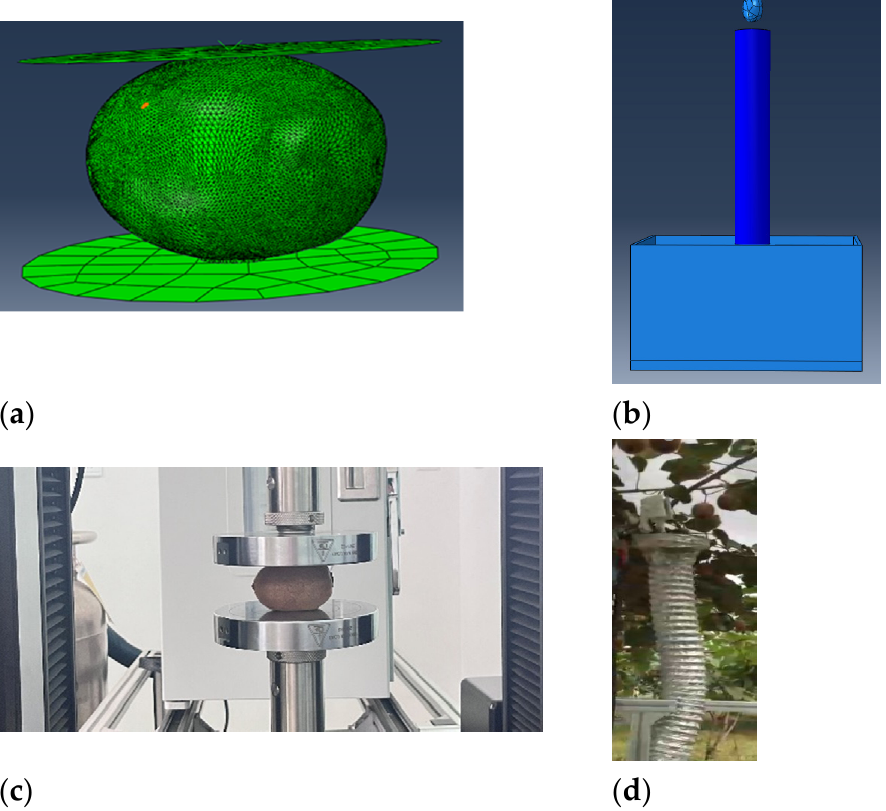
Figure 4. Kiwifruit grabbing and collection test and simulation. ( a ) Grab Kiwifruit simulation; ( b ) Container collection simulation; ( c ) Grab the kiwifruit test; ( d ) Container collection test. The third step involved defining the interactions between the system geometry models to limit the degrees of freedom between components (sub models). First, the elastic modulus of the kiwifruit peel was greater than the modulus of elasticity of the internal tissue, so the outer surface of the peel geometry was defined as the main surface and the inner surface was defined as the secondary surface. In the grasping kiwifruit model, the contact